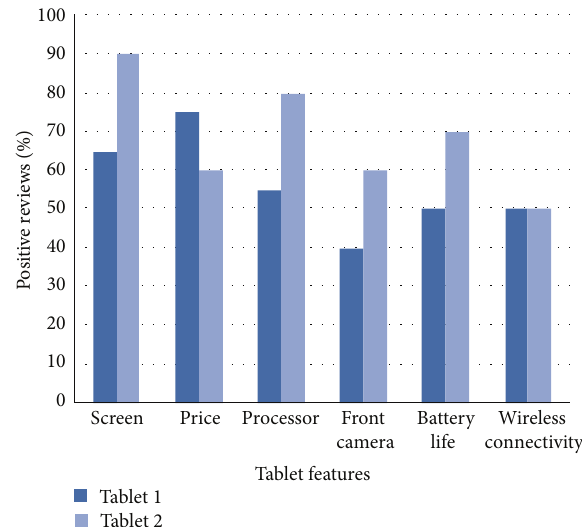
Figure 2: Comparative feature summary of two brands of